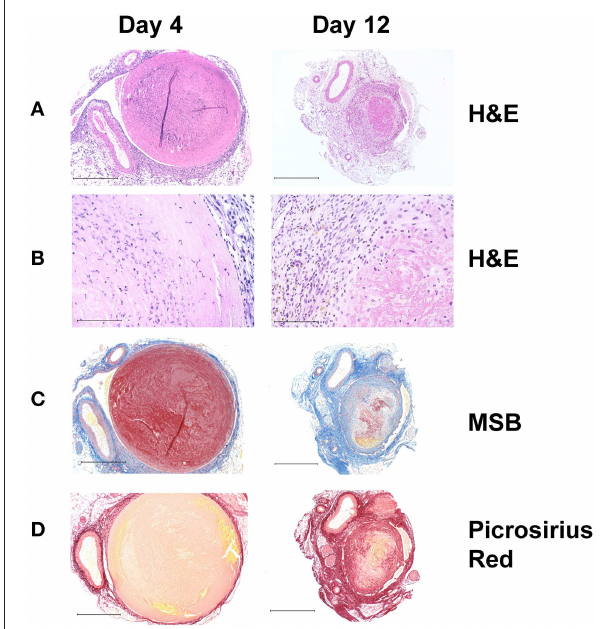
FIGURE 2 | Histochemical analysis of thrombus sections from a stasis induced mouse model of DVT. In this model, thrombus formation occurs maximally at day 4 and resolves naturally thereafter with day 12 serving as a measure of thrombus resolution. (A) Hematoxylin and Eosin (HandE) stain showing overall tissue morphology; (Original magnification x100, Scale bar 500 µ m) and (B) cell infiltrates. The nucleated cellular population at day 4 comprises mostly of neutrophils and few macrophages, whereas both macrophages and neutrophils can be seen at day 12 (Original magnification x400, Scale bar 100 µ m). (C) Martius Scarlet Blue (MSB) stain showing fibrin content in red (Original magnification x100, Scale bar 500 µ m). (D) Picrosirius Red stain showing collagen content in red (Original magnification x100, Scale bar 500 µ m). As the thrombus resolves, it becomes smaller in size, fibrin content is decreased via fibrinolysis and there is an increase in intrathrombus collagen